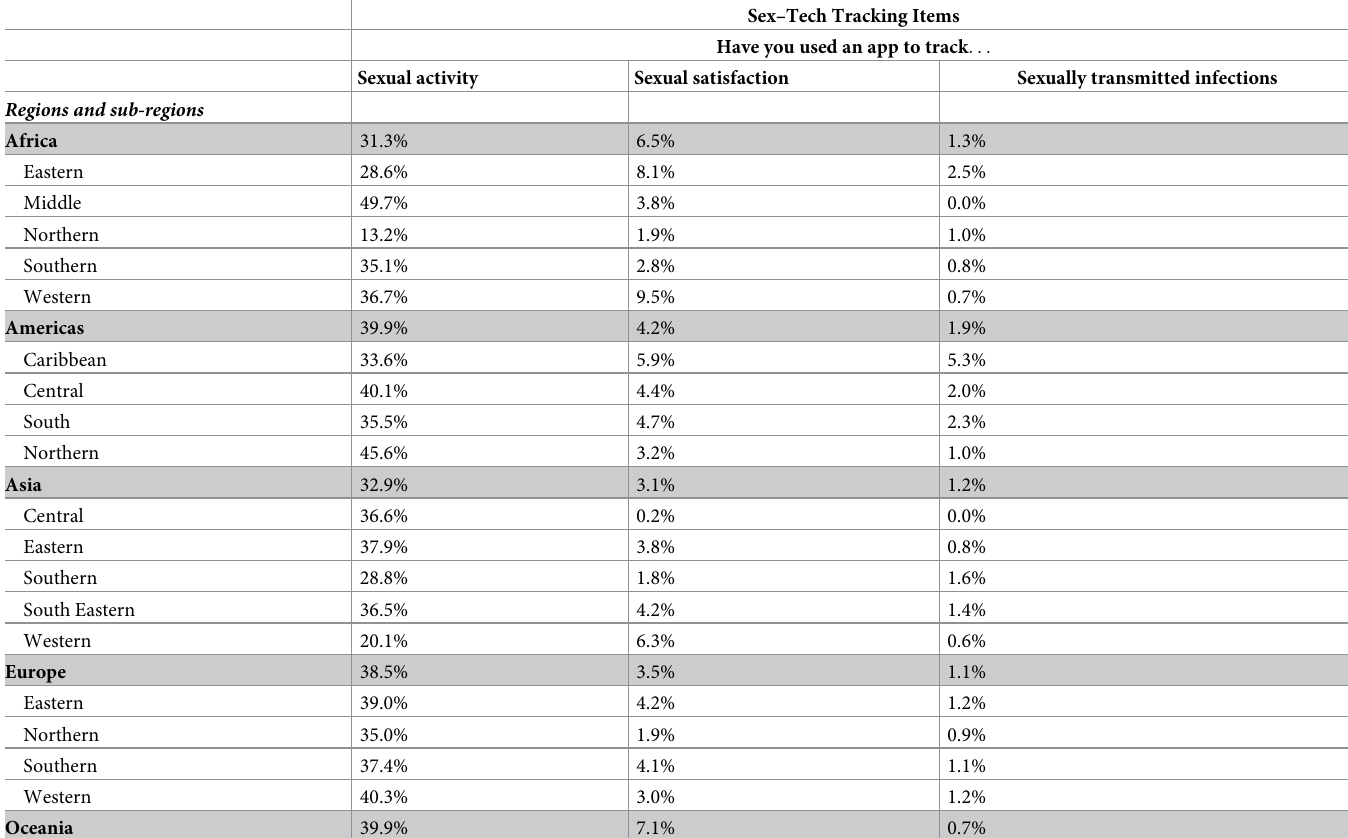
Table 4. Frequencies of those selecting “yes” to all items relating to tracking by UN-designated regions and